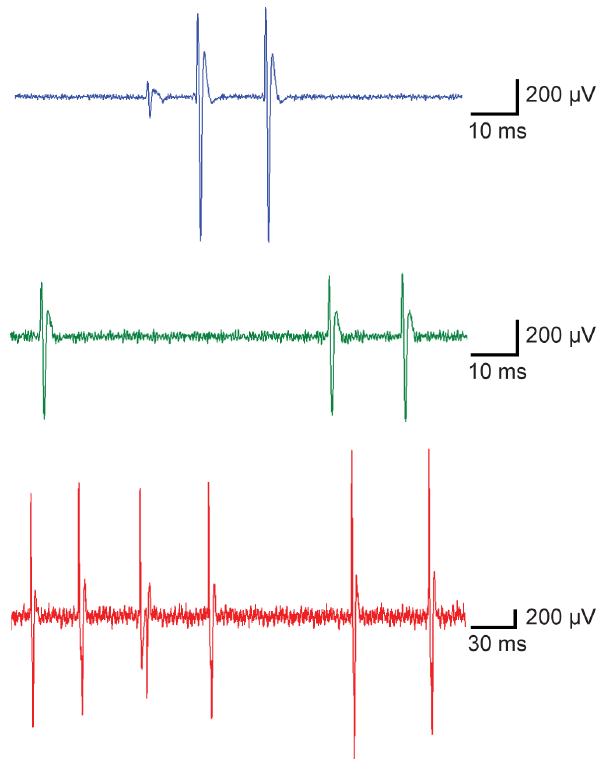
Figure 6. In vivo extracellular recordings from mouse brain somatosensory cortex. Three different extracellular recordings show well-isolated single unit activity.